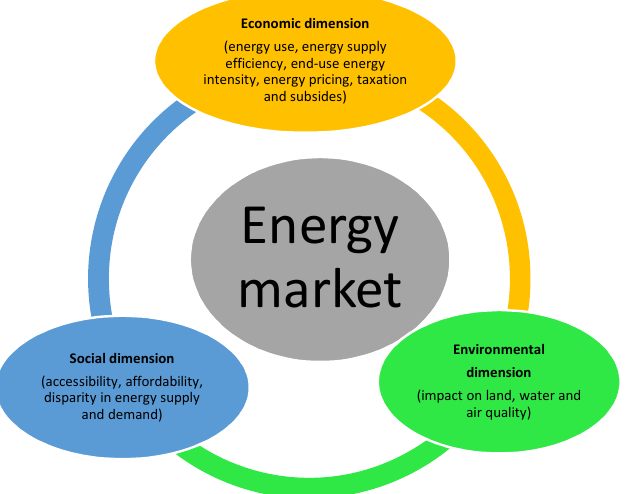
Figure 1. Inter-relationship among sustainability dimensions of the energy sector. Source (own elaboration).